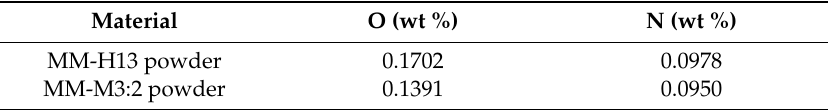
Table 3. Oxygen and nitrogen content in the MM